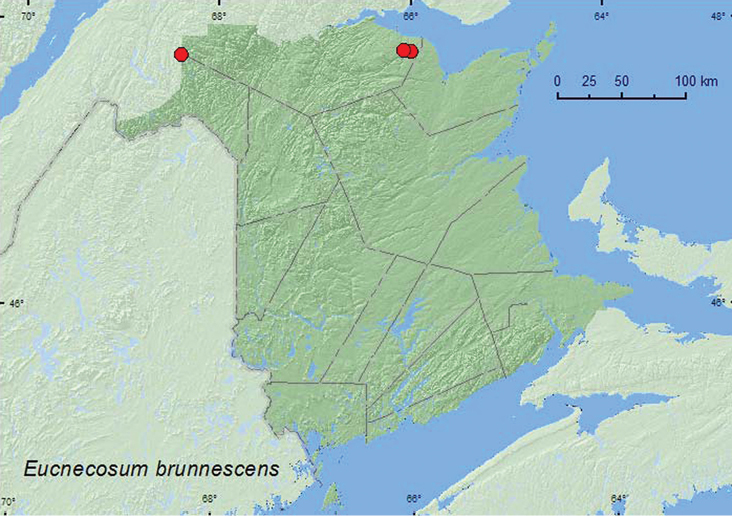
Collection localities in New Brunswick, Canada of Eucnecosum brunnescens.